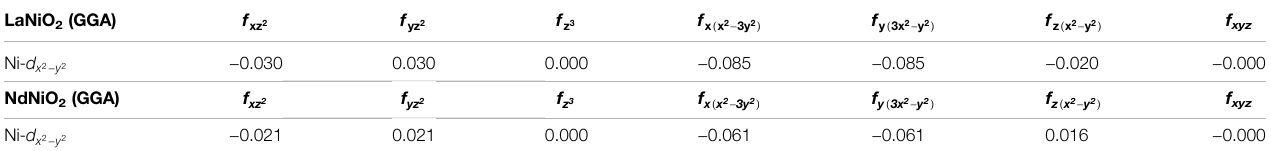
TABLE 2 | Hybridization (hopping amplitude in eV) between the Ni 3 d x 2 − y 2 and the Nd (La) 4 f orbitals, as obtained from Wannier projections onto 17-bands (La/Nd-4 f + La/Nd-5 d + Ni-3 d ), including the 4 f as valence states in DFT (GGA) [33]. LaNiO 2 (GGA)